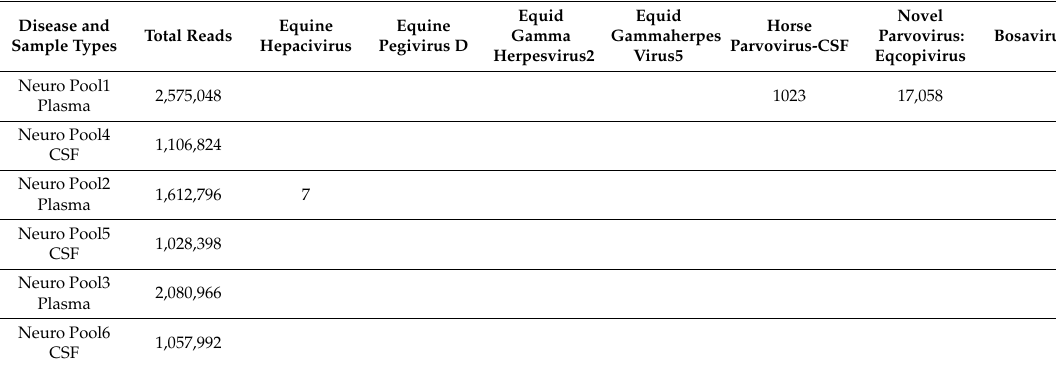
Table1. DistributionoftranslatedsequencereadswithsimilarityEscoreof < 10 − 10 toknownmammalian viral